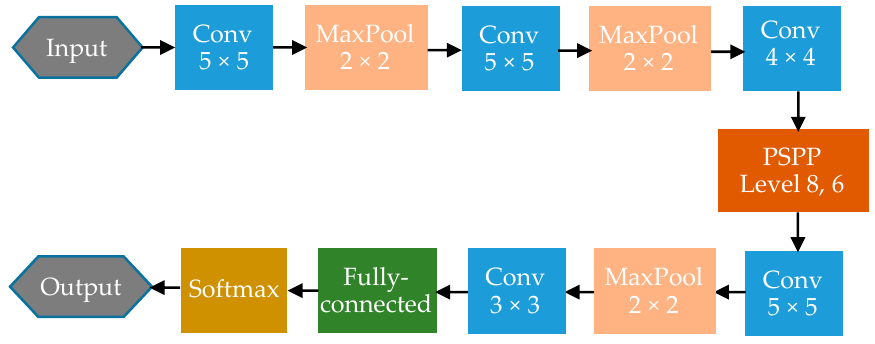
Figure 6. Structure of PSPP-CNN used in this paper. It is the PSPP-CNN used in all the following experiments, as PSPP-CNN has ability to process multi-size input.